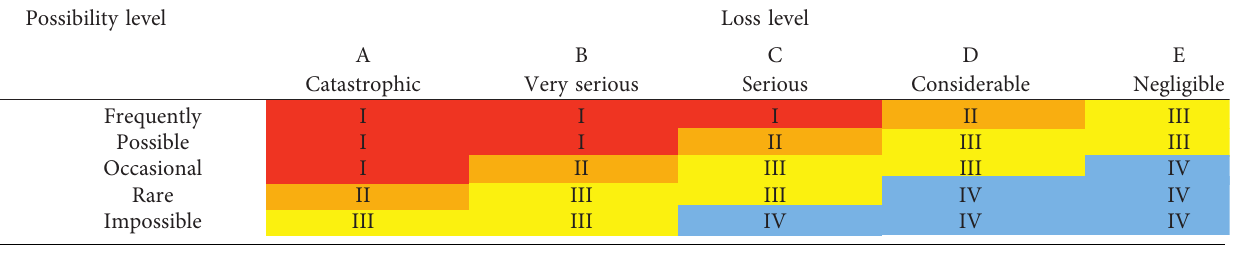
Table 9: Risk assessment matrix.